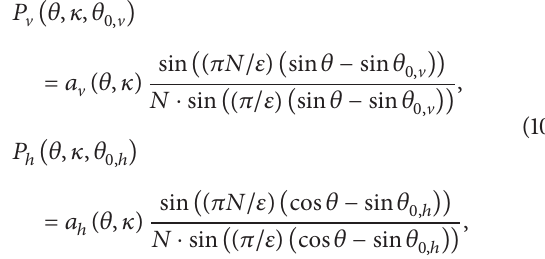
(𝜃, 𝜅, 𝜃 ) and 𝑃 (𝜃, 𝜅, 𝜃 ) denote the beam radiation V 0, V ℎ 0,ℎ